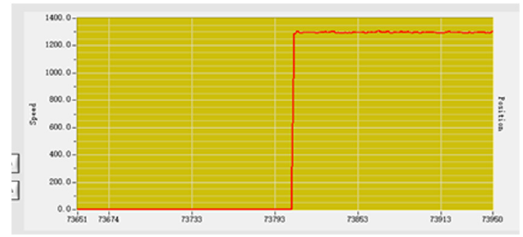
Figure 15. Adjust the previous speed curve.